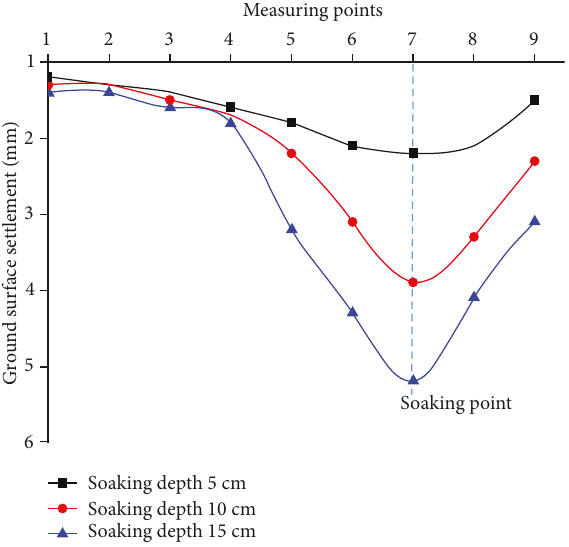
Figure 16: Ground surface settlement for half-range soaking.